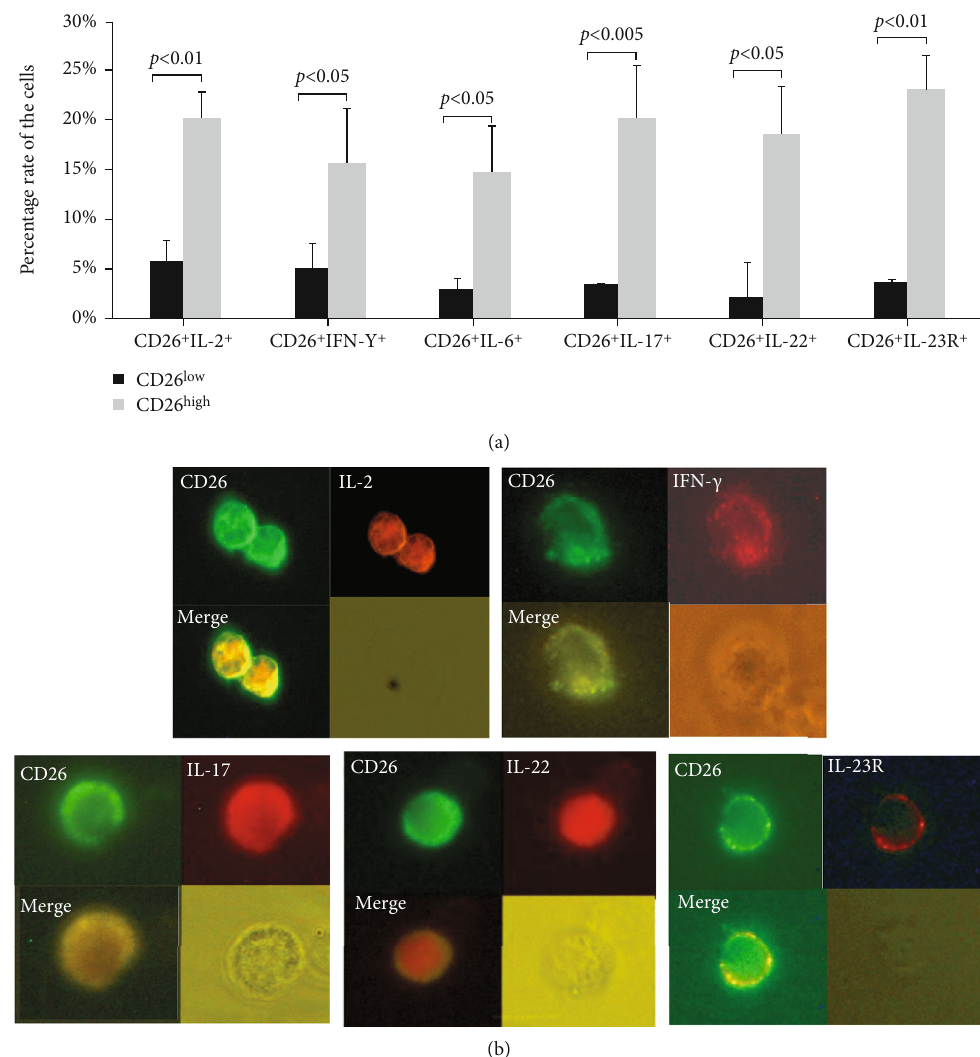
Figure 7: Coexpression of CD26 with each of the Th1 or Th17 typical cytokines or surface markers in the cells of the CD26 low and CD26 high groups. Lymphocytes were harvested at 72 h after stimulation and were double-stained with the FITC-conjugated anti-CD26 mAb and PE-conjugated anti-IL-2, anti-IFN- γ , anti-IL-17, anti-IL-6, anti-IL-22, or anti-IL-23R mAb. (a) Percentages of cells coexpressing CD26 with each of the Th1 typical cytokines (IL-2 or IFN- γ ), Th17 typical cytokines (IL-6, IL-17, and IL-22), or Th17 typical surface marker (IL-23R) in the CD26 low and CD26 high groups. Data represented mean value ± SD from a minimum of fi ve independent experiments with at least fi ve healthy donor HPBL samples, and each experiment was repeated more than three times. (b) Coexpression of CD26 with Th1 or Th17 typical biomarkers was observed by fl uorescence microscopy. Images were made at × 600 magni fi cations. Coexpression of CD26 with IL-2, IFN- γ , IL-17, IL-22, or IL-23R in some lymphocytes indicated by the merged